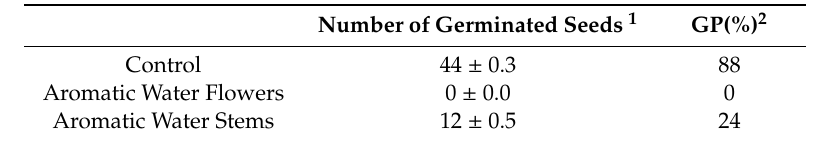
Table 4. Inhibition of Raphanus sativus seed germination by Lavandin flowers and stems aromatic waters.